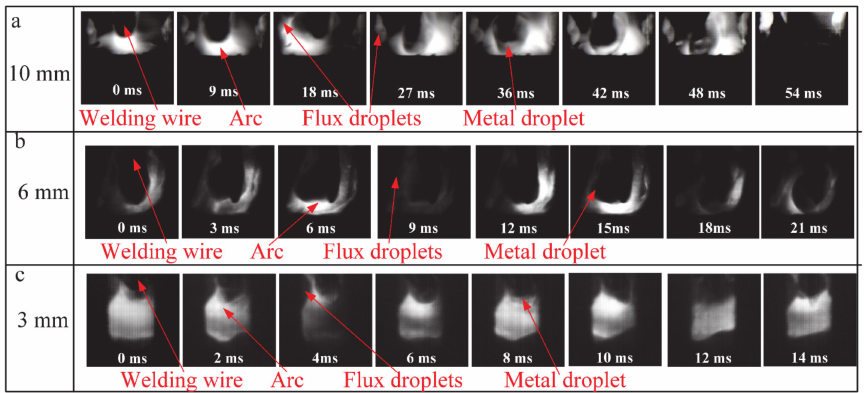
Figure 14. The metal transfers under di ff erent groove gaps in FBCA welding process. ( a ) 10 mm, ( b ) 6 mm, ( c ) 3